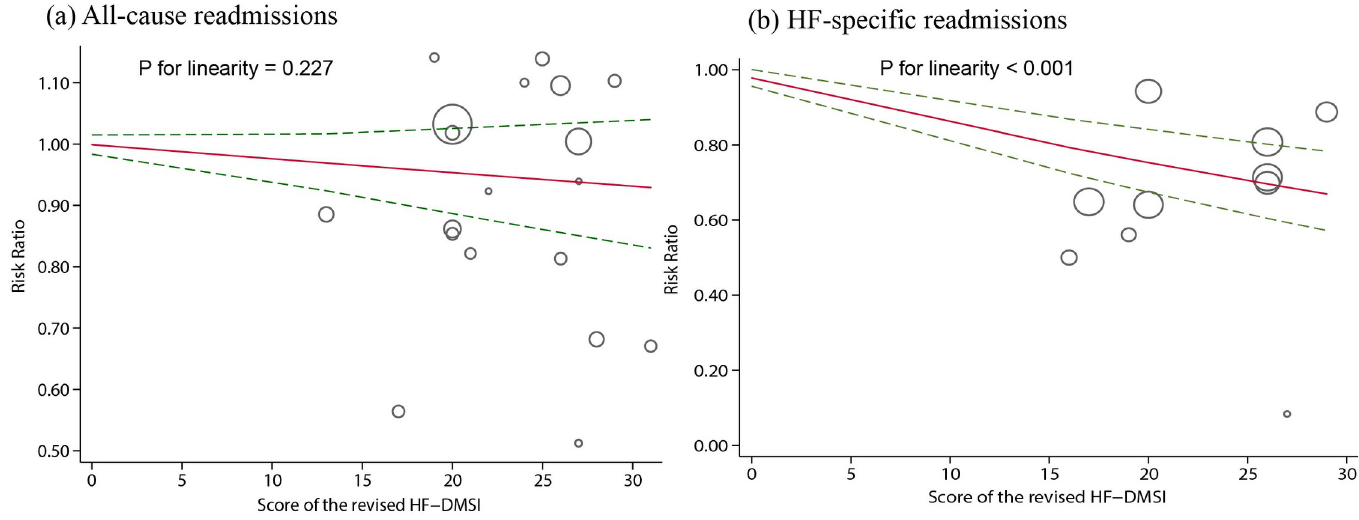
Fig 6. Dose-response relationship of the adapted HF-DMSI score with (a) all-cause readmissions and (b) HF-specific readmissions.